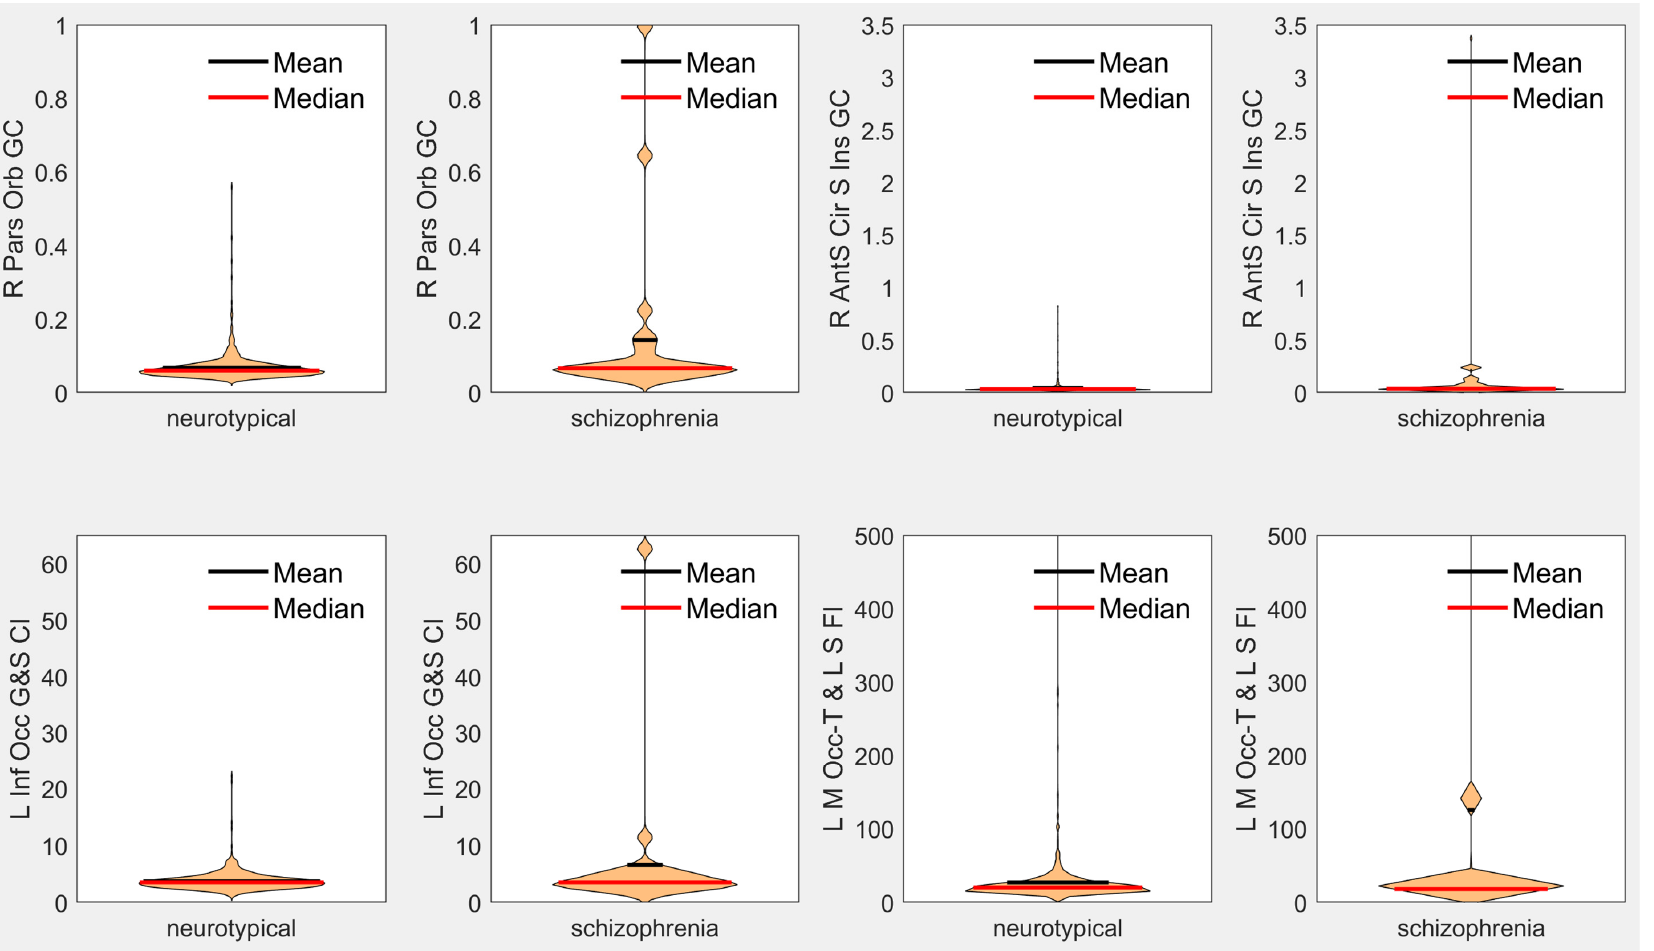
Figure 1. Violin plots of leading measurements from Table 2 of each type. R = right, L = left, Orb = Orbitalis, GC = Gaussian Curvature, AntS = Anterior Segment, Cir = Circular, S = Sulcus/Sulci, Inf = Inferior, Occ = Occipital, G = Gyrus, CI = Curvature Index, FI = Folding Index, M = Medial, Occ-T = Occipito- Temporal, L = Lingual.